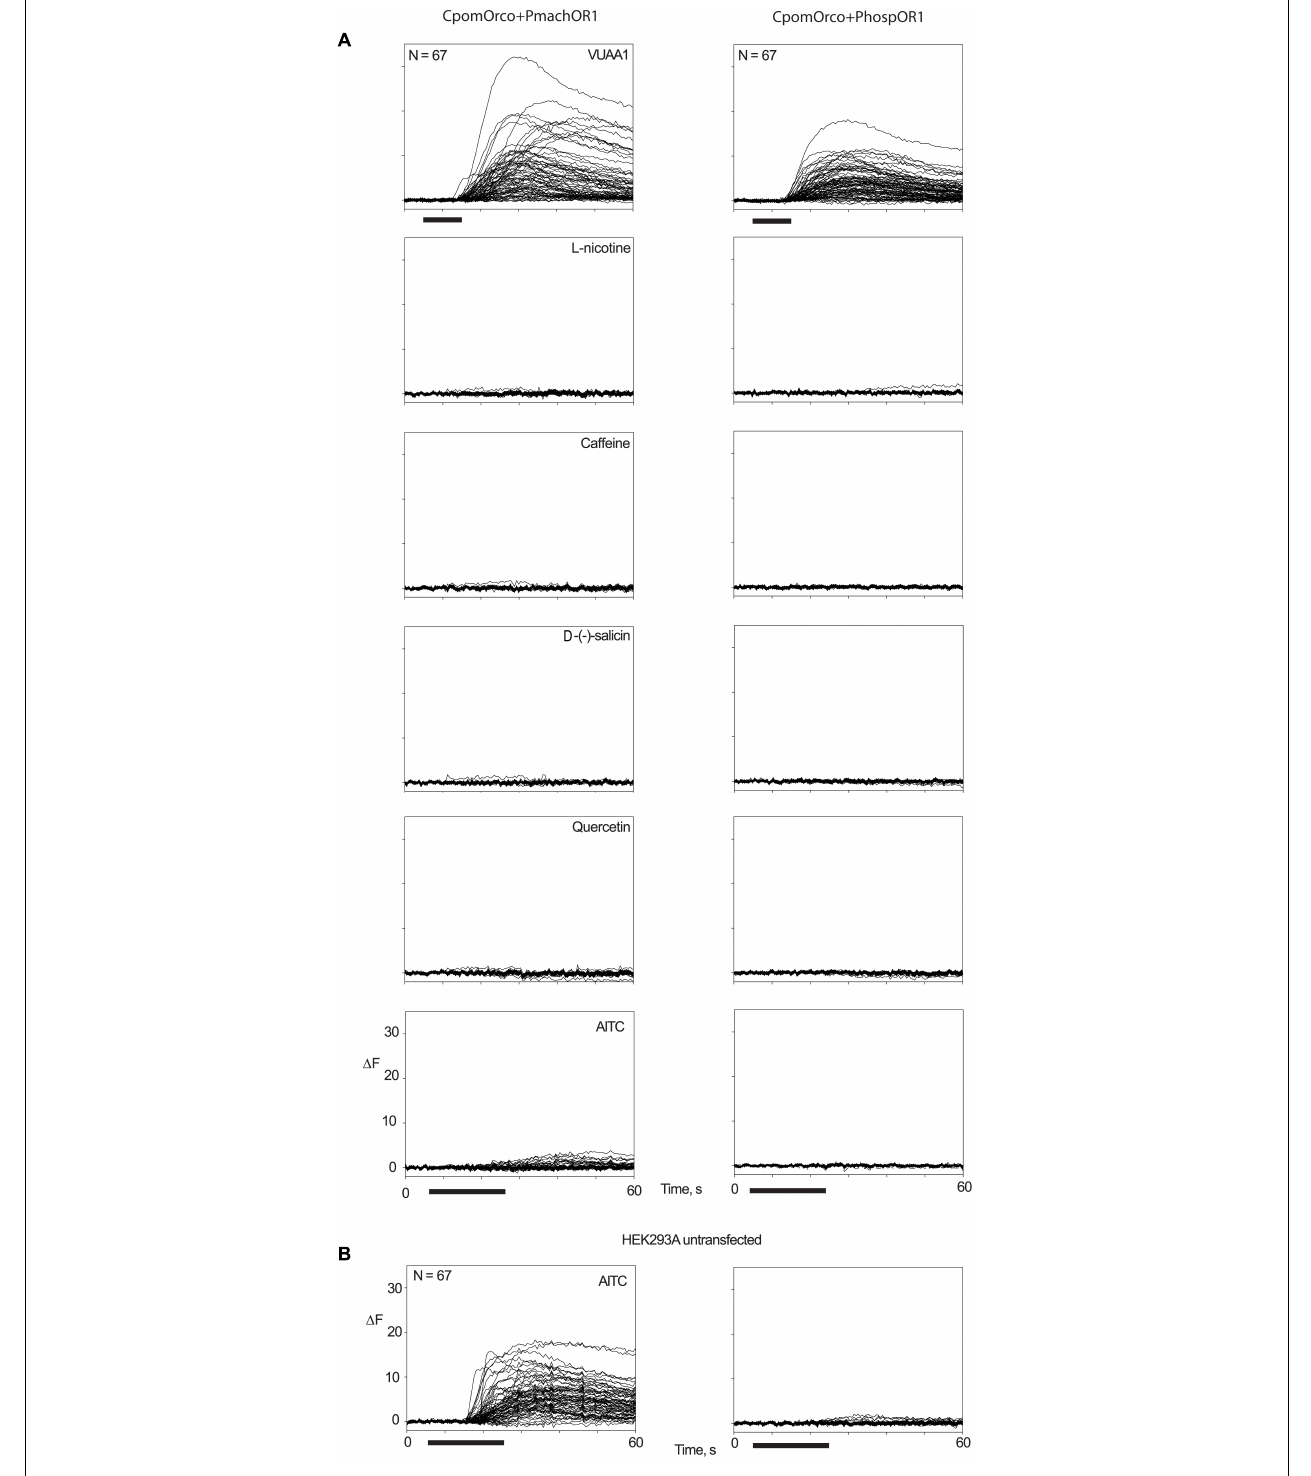
FIGURE 6 | Screening of candidate ligands on OR1. Multiple traces of fluorescence variation associated with Ca ++ i increase in HEK293A cells transfected with CpomOrco + PmachOR1 (left) and CpomOrco + PhospOR1 (right). (A) Application of 500 µ M doses of VUAA1, L-nicotine, caffeine, D-(-)-salicin, quercetin, and AITC. (B) Two consecutive applications of AITC (500 µ M) to non-transfected HEK293A. A reversible effect on non-transfected cells was observed, excluding its relations with the human TRPA1 (Cattaneo et al., 2017b), which is in accordance with the documented absence of TRPA1-transcripts in HEK cells (BioGPS Cell Line Gene Expression Profiles—HEK293). N = 67 for all experiments; black bar: stimulus (10 s for VUAA1, 20 s for ligands).